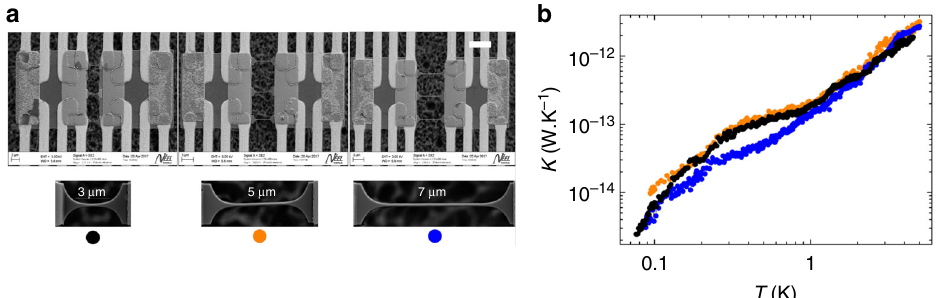
Fig. 4 Thermal conductance measurements of nanowires having three different lengths as a function of temperature. a SEM images of the three different nanowires suspended between the membranes having a length between the two contacts of 3 μ m (black dots), 5 μ m (orange dots), and 7 μ m (blue dots) for a constriction size w = 2 μ m. Scale bar 5 μ m. b Thermal conductances of the three nanowires as a function of temperature. The measurements are mostly superposed showing that the phonon mean free path is at least >7 μ m whatever the